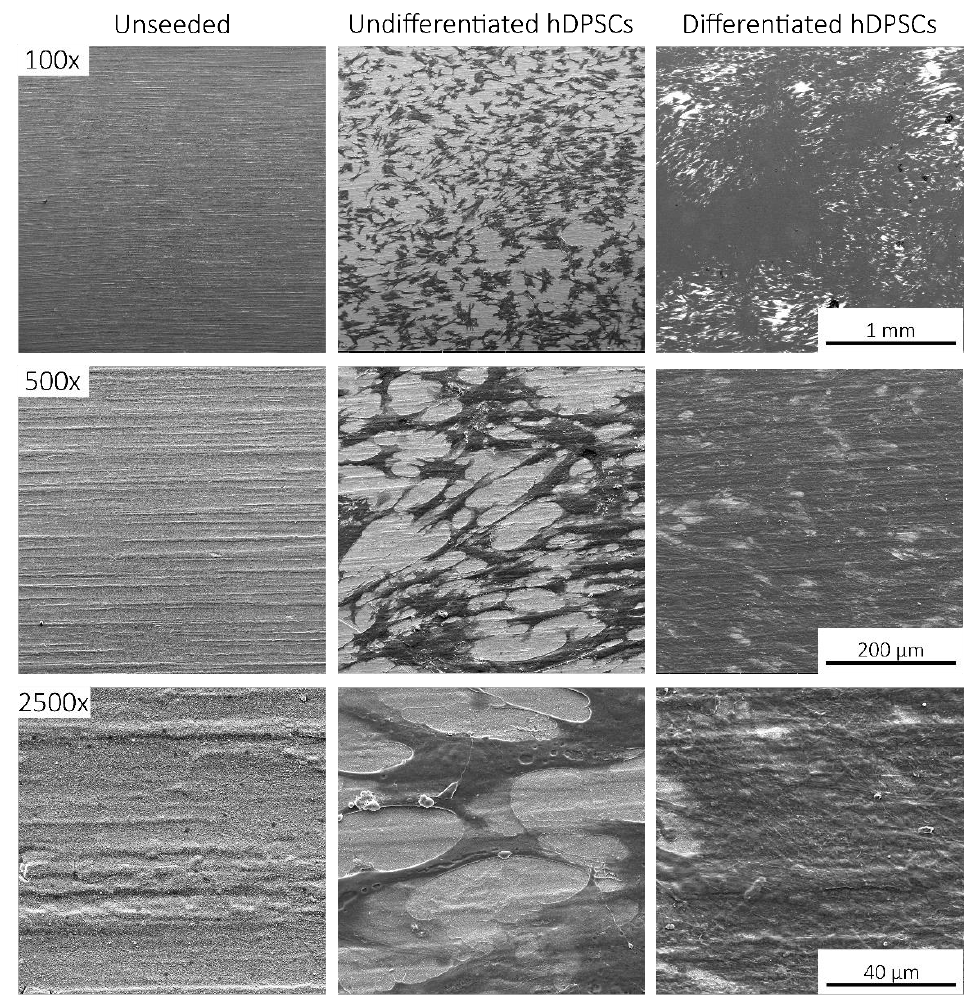
Figure 4. SEM images for the SS/SIL group. Upper panel 100× magnification, middle panel 500× magnification, and lower panel 2500× magnification. First column: Unseeded devices; middle column: Seeded undifferentiated hDPSCs devices; third column: Seeded differentiated hDPSCs devices.